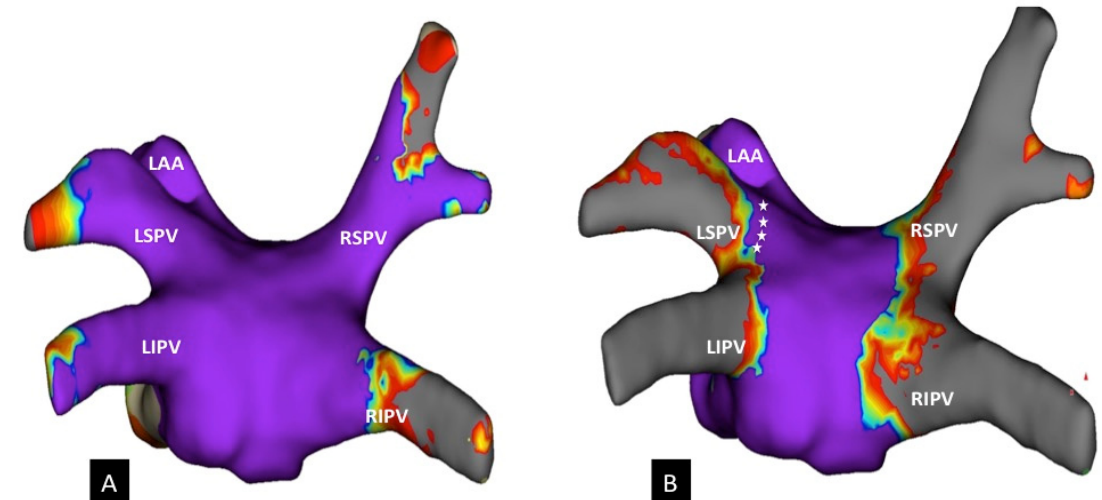
Figure 3. 3D-HD map of the left atrium in a posterior–anterior view (PA). ( A ) The initial map before cryoballoon ablation. ( B ) Lesion extension after CB-based PVI in a posterior–anterior view. The white asterisks mark an area with preserved bipolar voltage at the posterior superior antrum of the LSPV. 3D-HD, high-density; RSPV, right superior pulmonary vein; RIPV, right inferior pulmonary vein; LSPV, left superior pulmonary vein; LIPV, left inferior pulmonary vein; LAA, left atrial appendage.